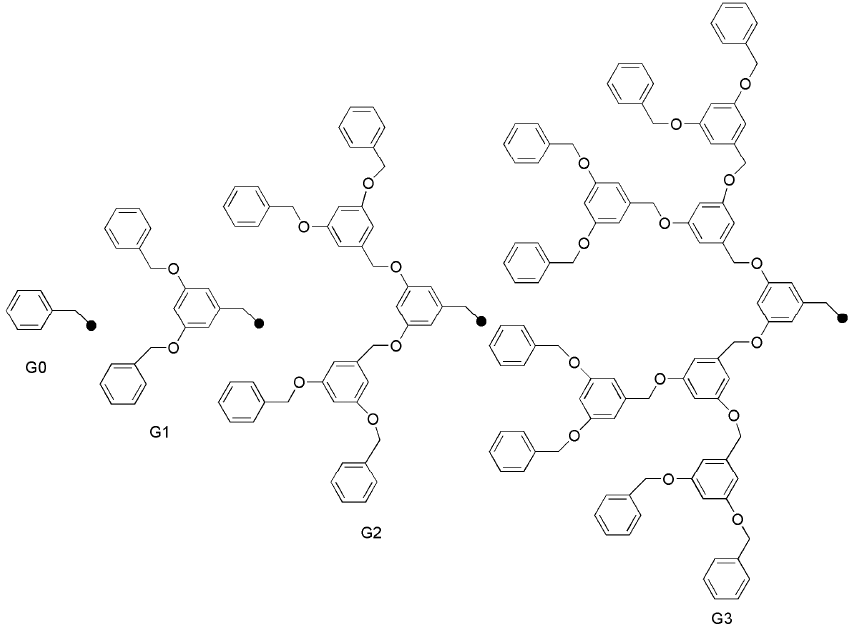
Figure 27. Structures of dendrons used for the synthesis of bulky bis(imidazolium) salts [198].